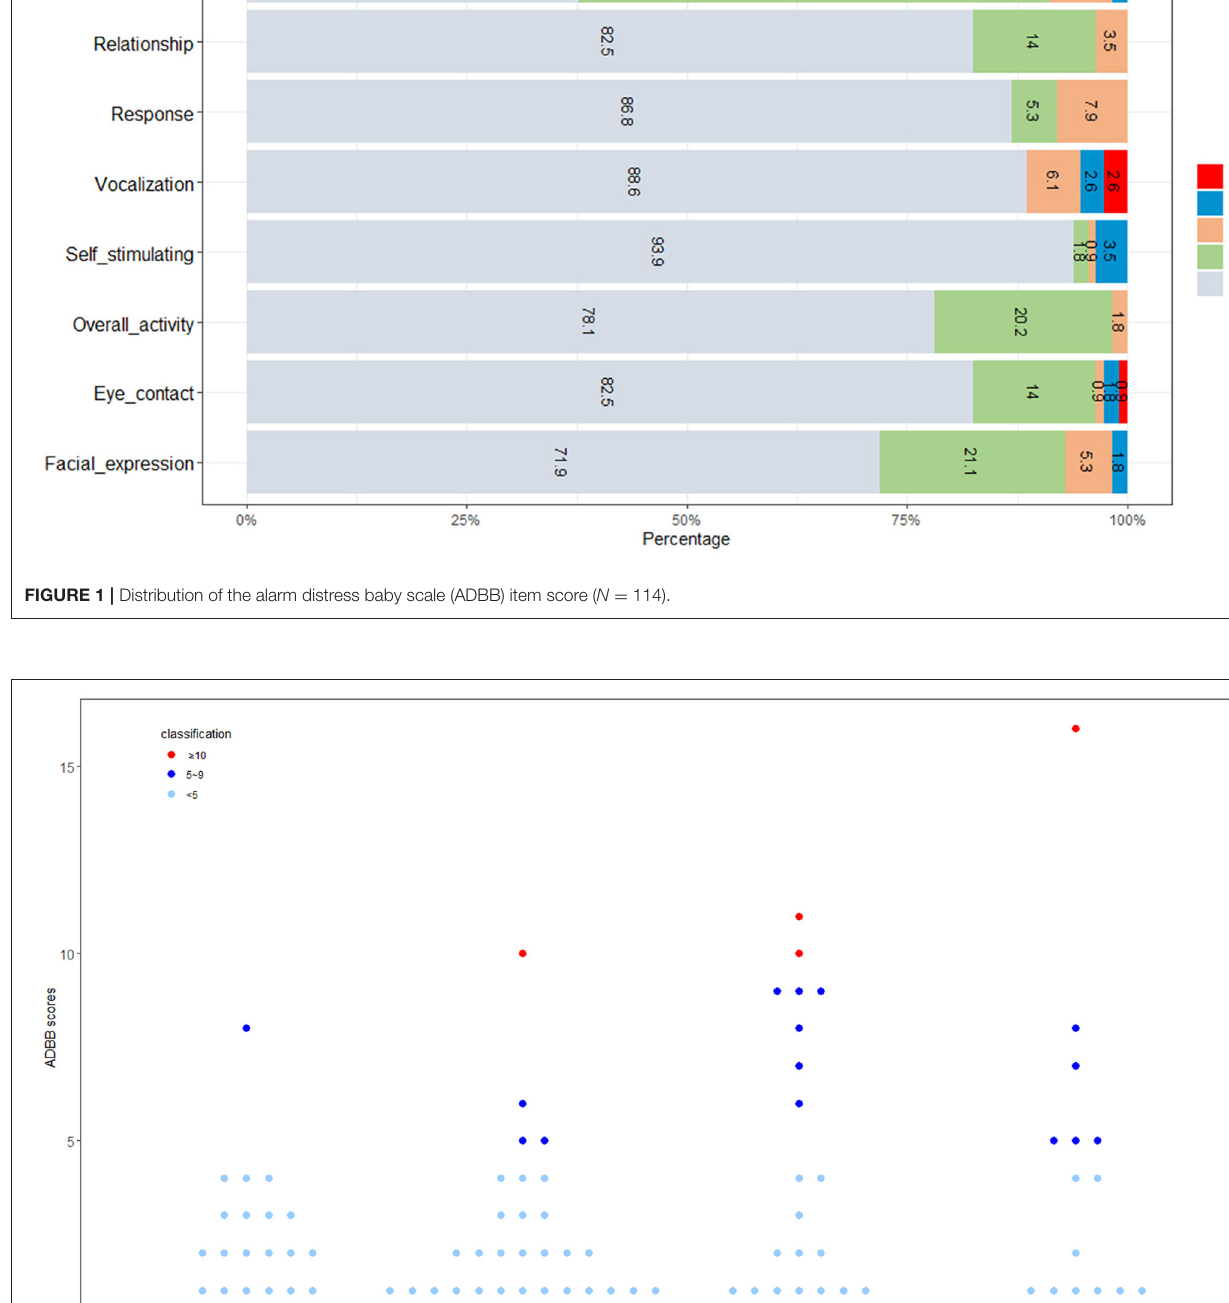
Frontiers in Psychiatry |